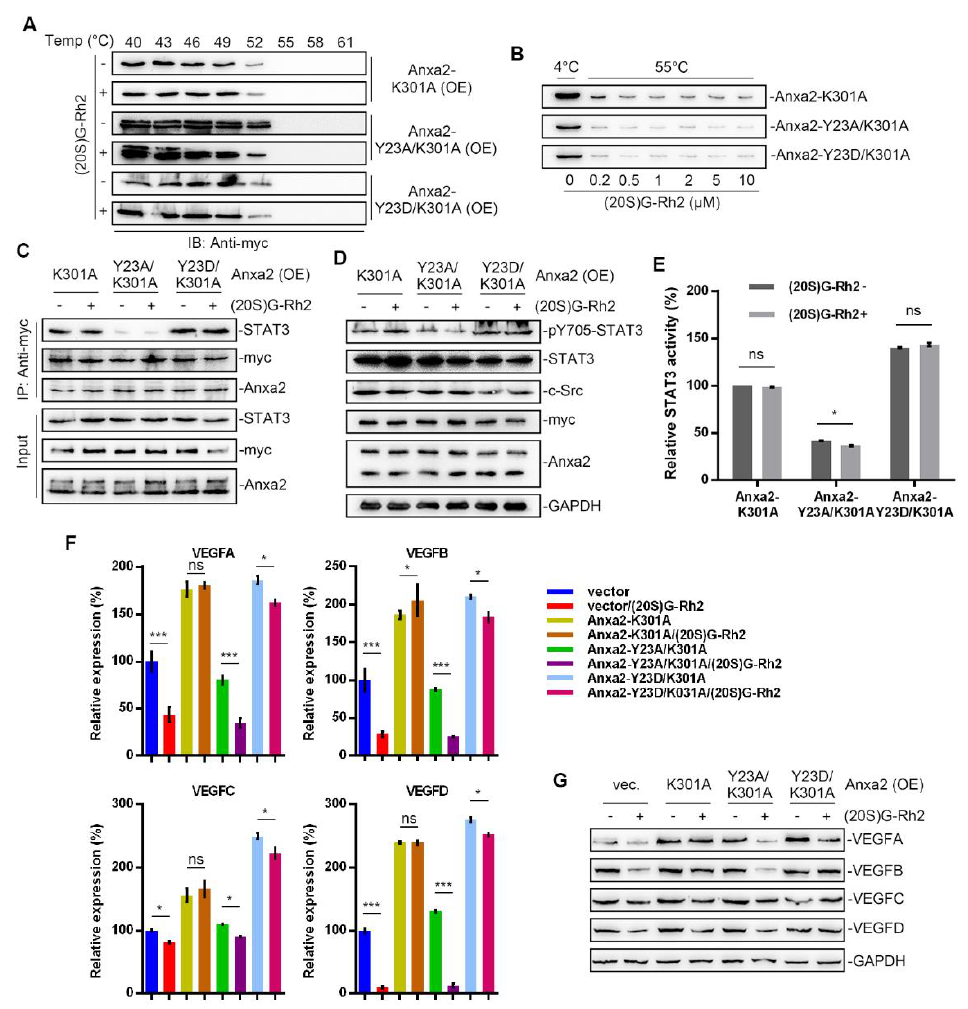
Figure 7. Anxa2-K301A mutant protected HepG2 cells from (20S)G-Rh2-induced STAT3 inhibition. Myc-tagged K301A, Y23A/K301A mutant and Y23D/K301A mutant of Anxa2 was over-expressed in HepG2 cells. ( A ) Cellular thermal shift assay was performed with (20S)G-Rh2 at the indicated temperature gradient in Anxa2-over-expressed HepG2 cells, and determined by immuno-blotting. ( B ) Thermal shift assay was performed with purified Anxa2 mutant and (20S)G-Rh2 gradient at 55 °C, and determined by immuno-blotting. ( C – E ) HepG2 cells with Anxa2 over-expression were treated with (20S)G-Rh2. Immuno-precipitation with anti-Anxa2 antibody ( C ) and protein level ( D ) were determined by immuno-blotting. STAT3 activation was determined via reporter gene assay ( E ). ( F , G ) Expression of four VEGFs in (20S)G-Rh2-treated HepG2 cell was determined by qRT-PCR ( F ) and immuno-blotting ( G ). Significance analysis was shown as * ( p < 0.05) and *** ( p < 0.001).